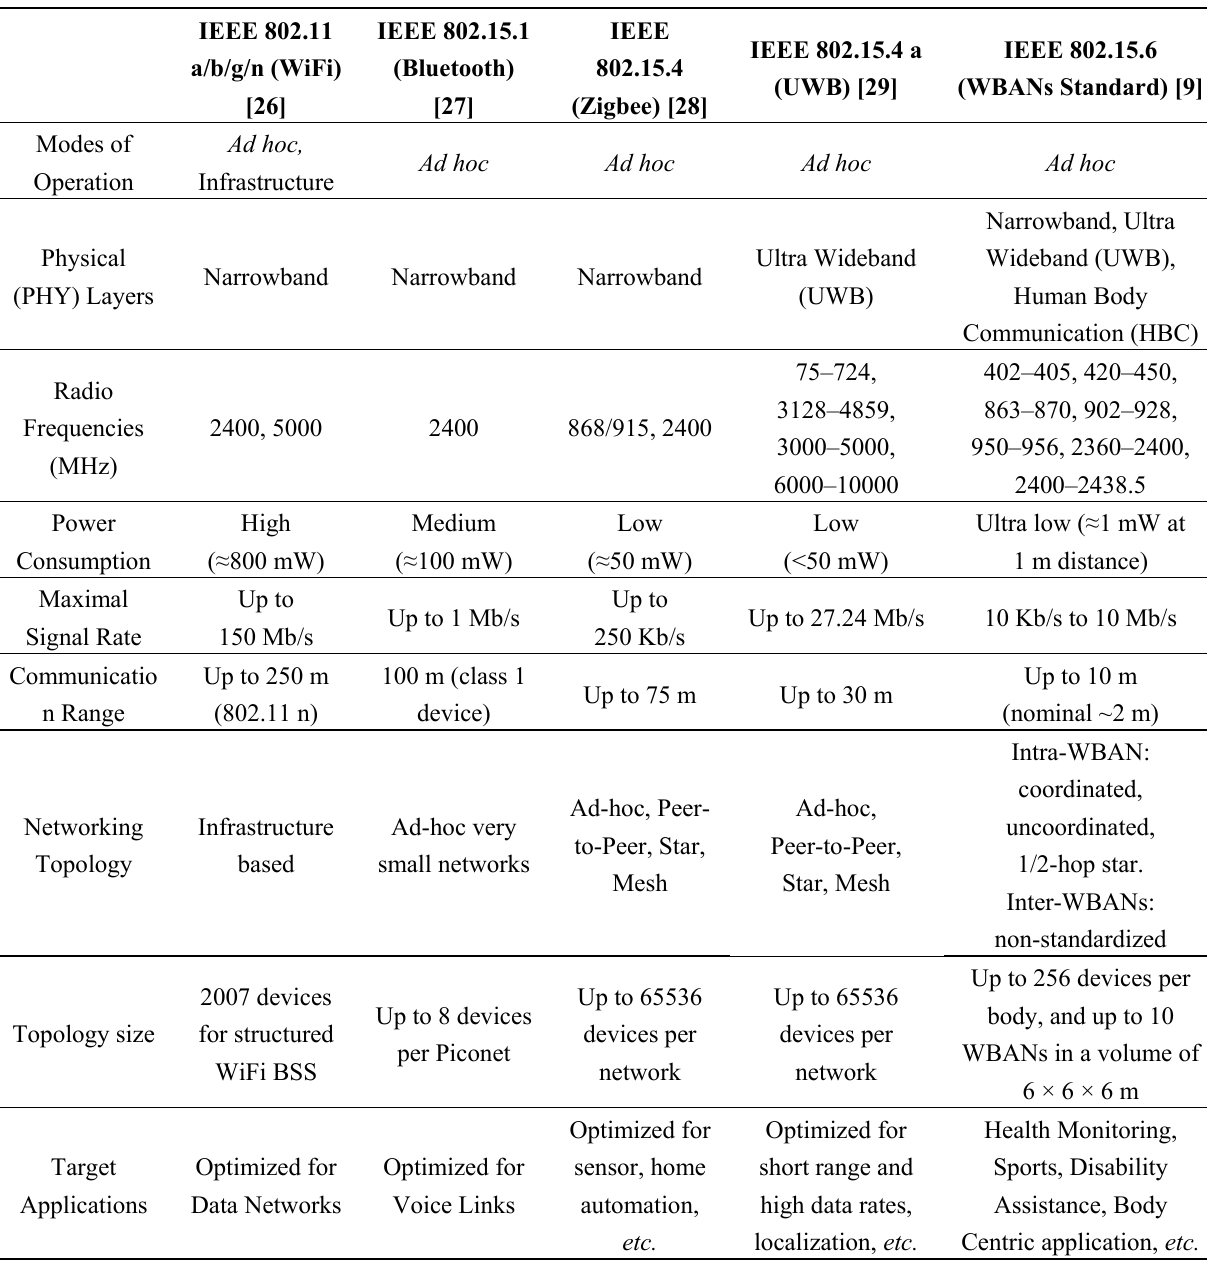
Table 3. WBAN-Related